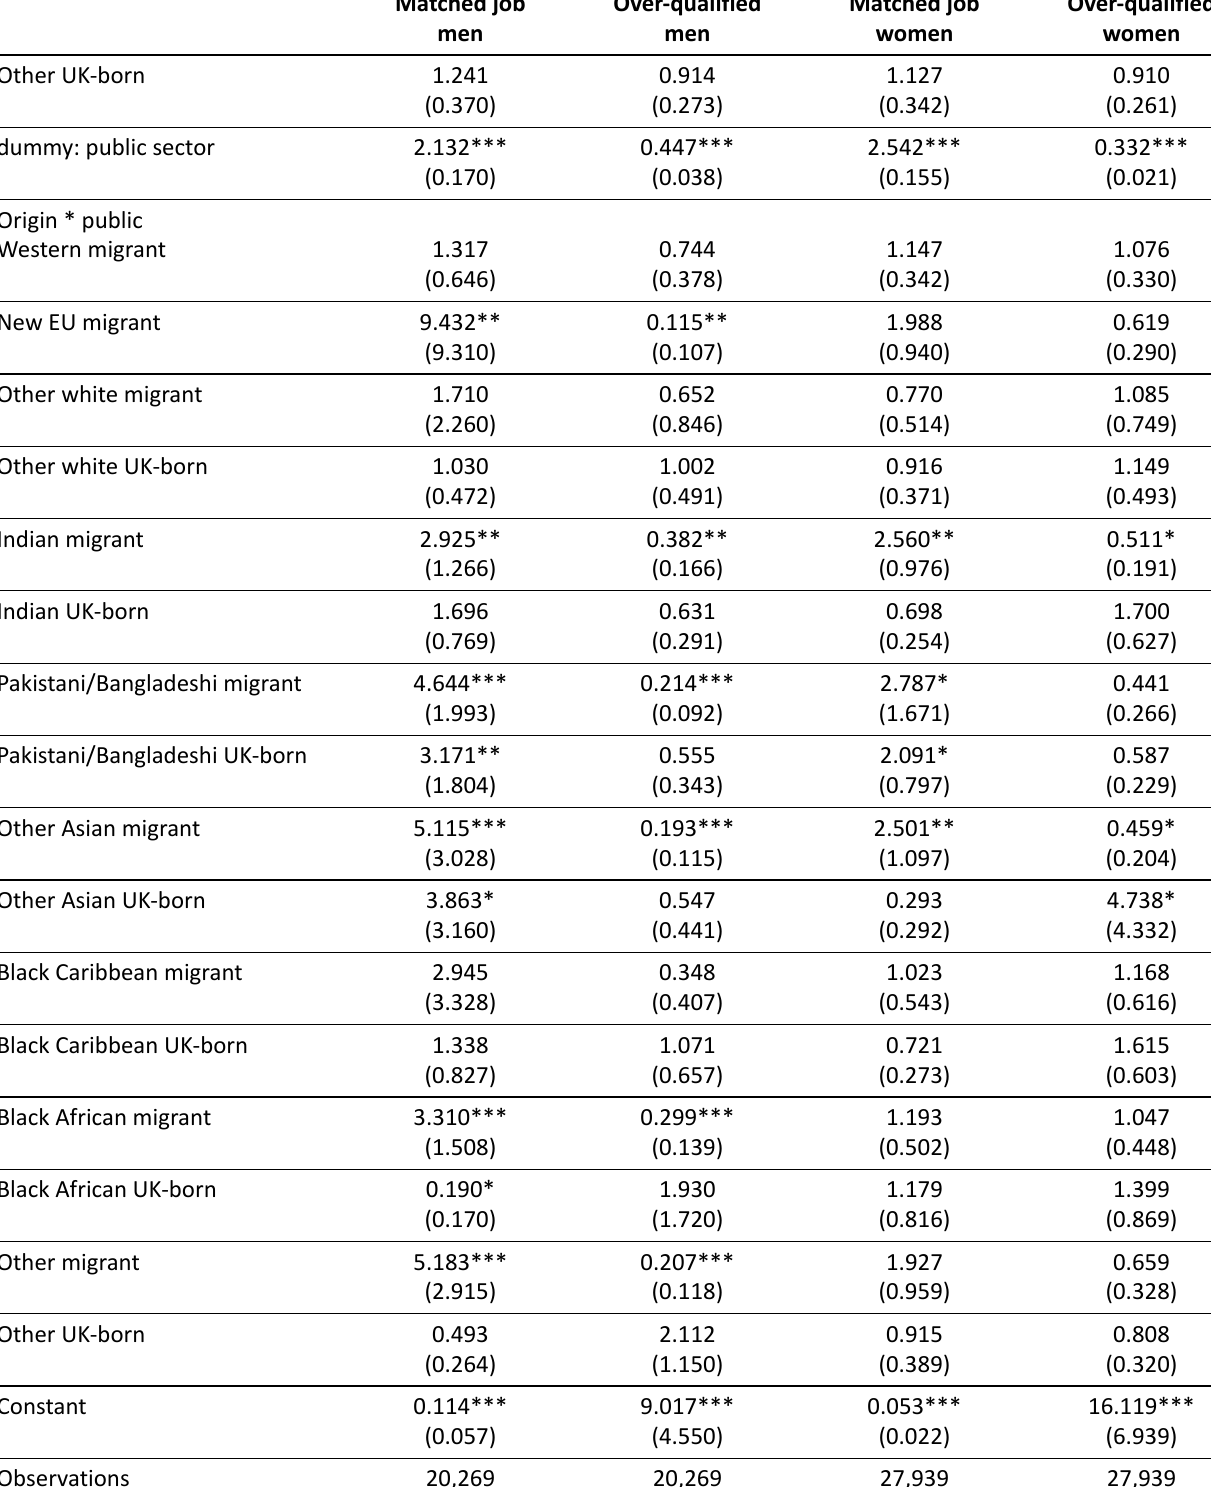
Table A7. (Cont.) Binary logistic regression model on matched job and over-qualification, interacting origin with sector of